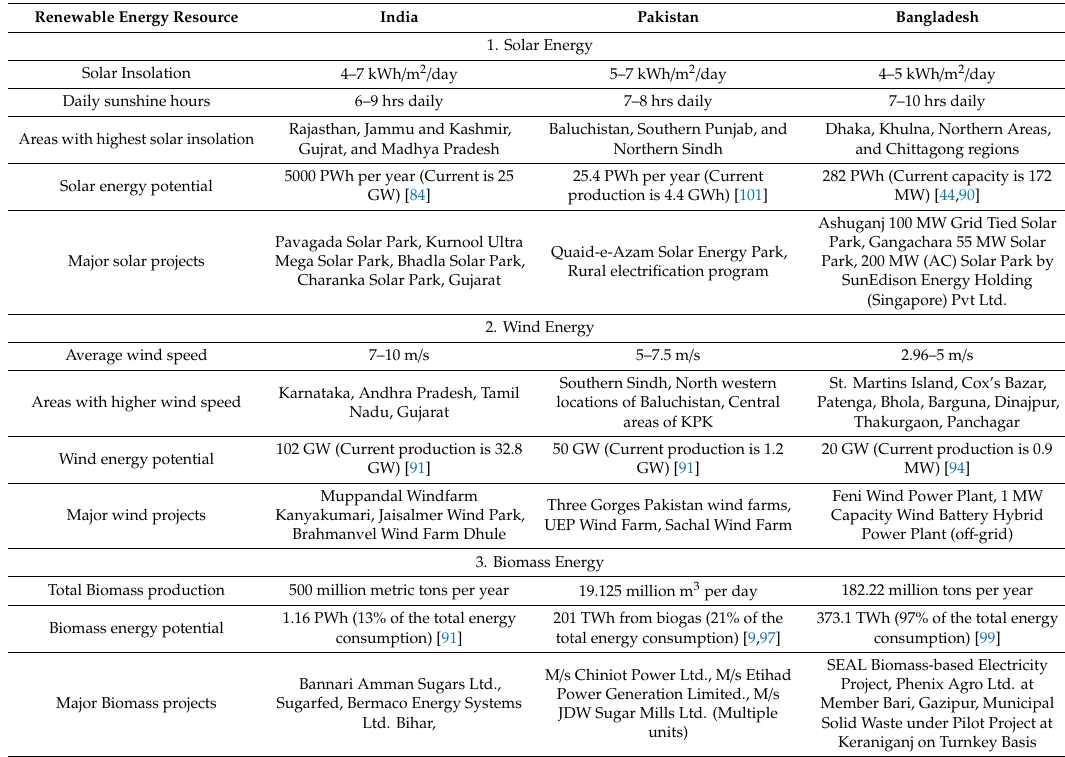
Table 2. Comparison of RERs potential in